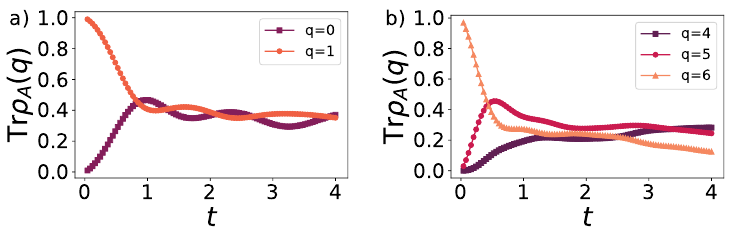
Figure 9: Population of the symmetry sectors during the evolution of the systems described in Fig.s5. We consider a system with L = 8 and we take A = [ 1,2,3,4 ] and B = [ 5,6,7,8 ] Here we fix U = 0.5 J , γ = 0.1 J and start from a) | ψ | ψ 〉 = | 1,2 〉 ⊗ L / 2 . 0